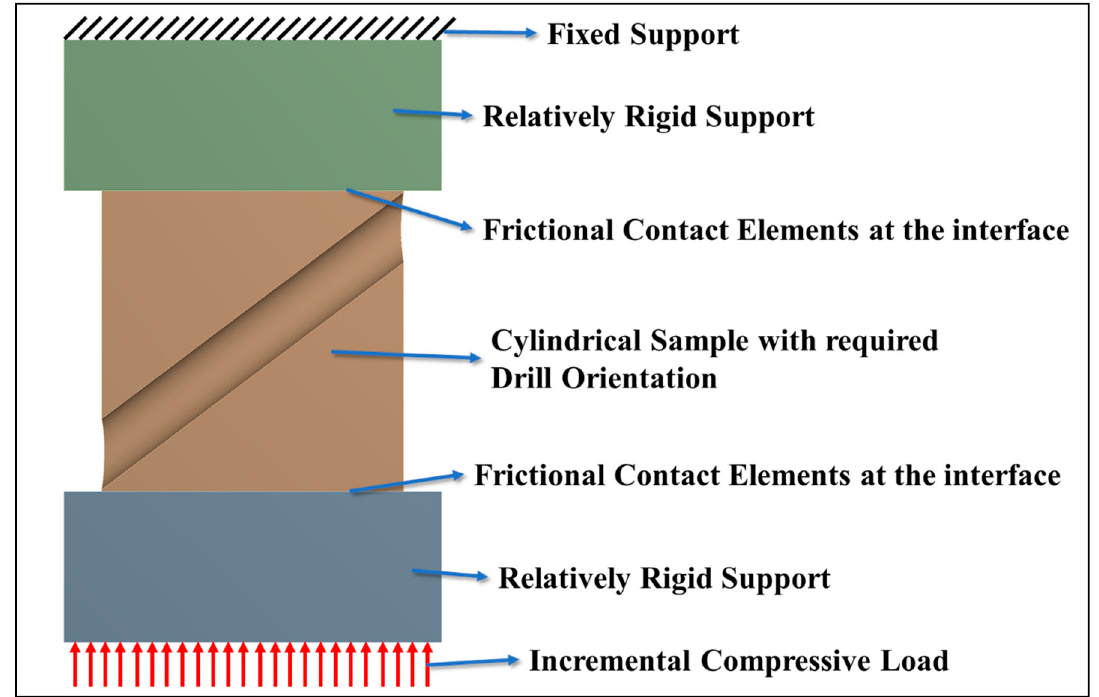
Figure 4. Illustration of the loading and boundary conditions used during simulations of different drill hole orientations.